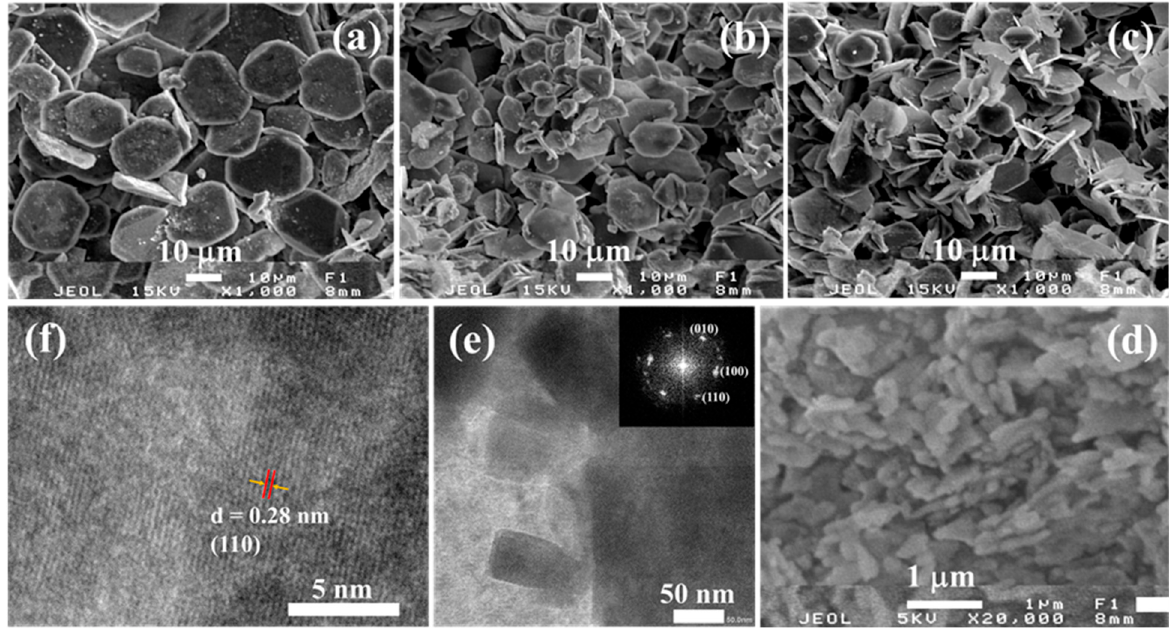
Figure 2. SEM images of KTFM prepared with different OA/SDS weight ratios of ( a ) 0.0, ( b ) 2.0, ( c ) 6.0 and ( d ) ~10.0. ( e ) TEM image and ( f ) HRTEM image of KTFM nanosheets. Inserted picture shows SAED pattern of KTFM nanosheets.